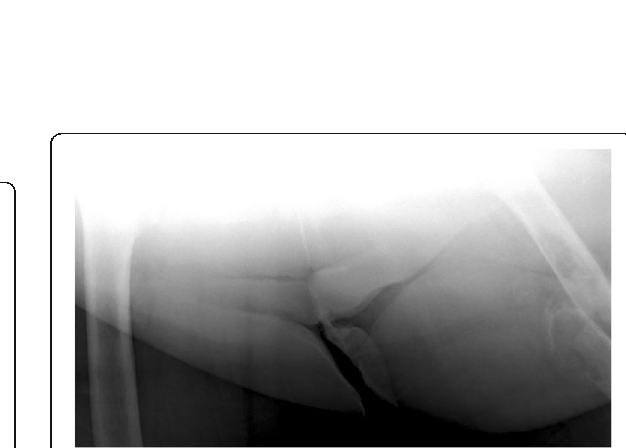
Fig. 9 Patient presented with left upper leg pain without history of trauma. The pelvic radiograph showed a displaced fracture of the left femoral shaft with associated lytic lesions